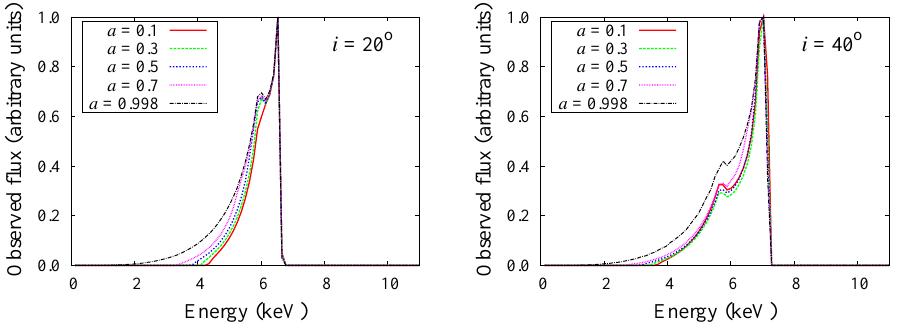
Fig. 2. Modeled Fe K (cid:11) spectral line profiles for several values of angular momentum parameters a , and for the inclination angle i = 20 ◦ (left panel) and i = 40 ◦ (right panel).